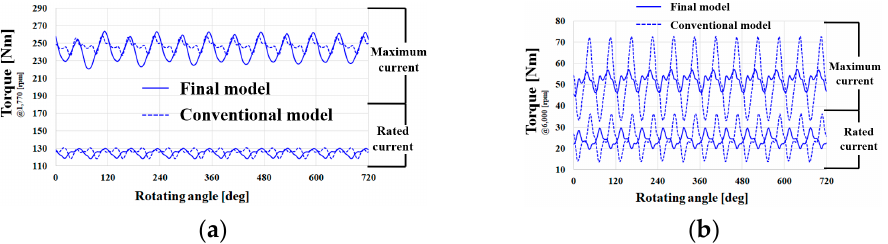
Figure 20. Comparison of rated and maximum torque waveforms at rated and maximum speed of the conventional model and final proposed model: ( a ) Torque at rated speed, ( b ) Torque at maximum speed.